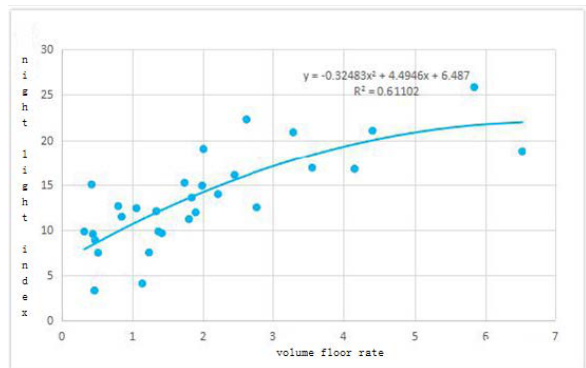
Figure 3. Regression analysis of the building volume floor rate and night light index.